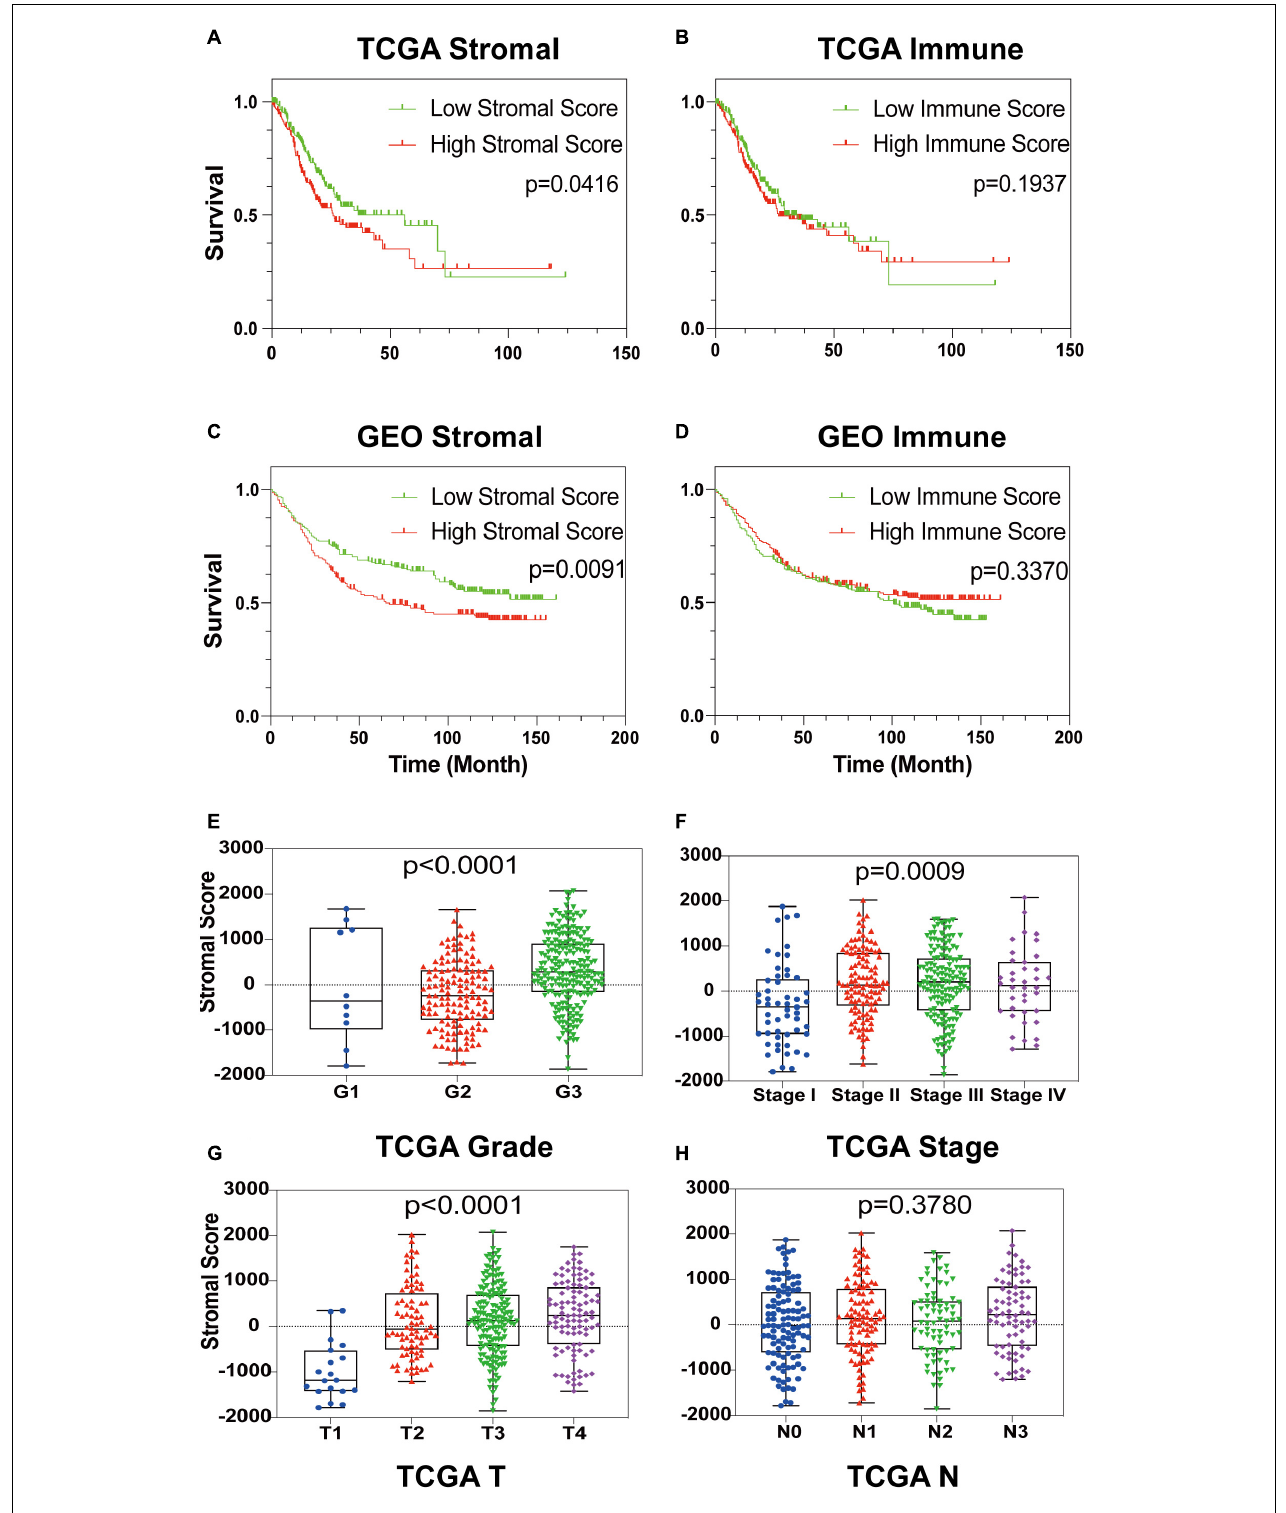
FIGURE 1 | Identification of GC Stromal Scores’ linkage with prognosis and clinicopathology. (A–D) Kaplan–Meier survival analysis of TCGA STAD patients and GEO GSE84437 patients grouped by immune score and stromal score. The red line indicates the high ESTIMATE score group, and the green line indicates the low ESTIMATE score group. (E–H) The relationship between the TCGA ESTIMATE stromal score and tumor grade, clinical stage, T stage and N stage. Each dot signifies the stromal score in a sample.